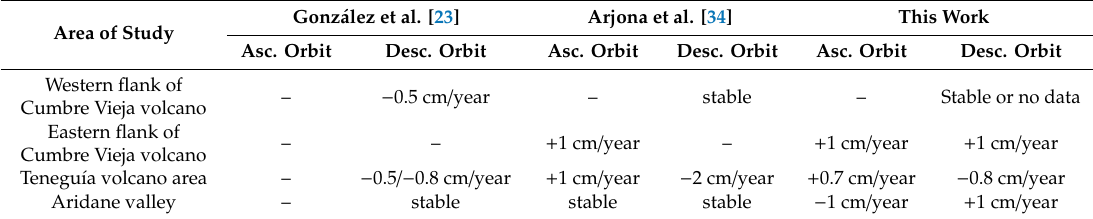
Table 3. Comparison of A-DInSAR results obtained using ENVISAT data for La Palma. The sign convention used by Gonz á lez et al. [23] was reversed, for the sake of comparison, to the one in this work. Gonz á lez et al. [23] Arjona et al. [34] This Work Area of Study Asc. Orbit Desc. Orbit Asc. Orbit Desc. Orbit Asc. Orbit Desc. Orbit Western flank of – − 0.5 cm / year – stable – Stable or no data Cumbre Vieja volcano Eastern flank of – – + 1 cm / year – + 1 cm / year + 1 cm / year Cumbre Vieja volcano Tenegu í a volcano area – − 0.5 / − 0.8 cm / year + 1 cm / year − 2 cm / year + 0.7 cm / year − 0.8 cm / year Aridane valley – stable stable stable − 1 cm / year + 1 cm /